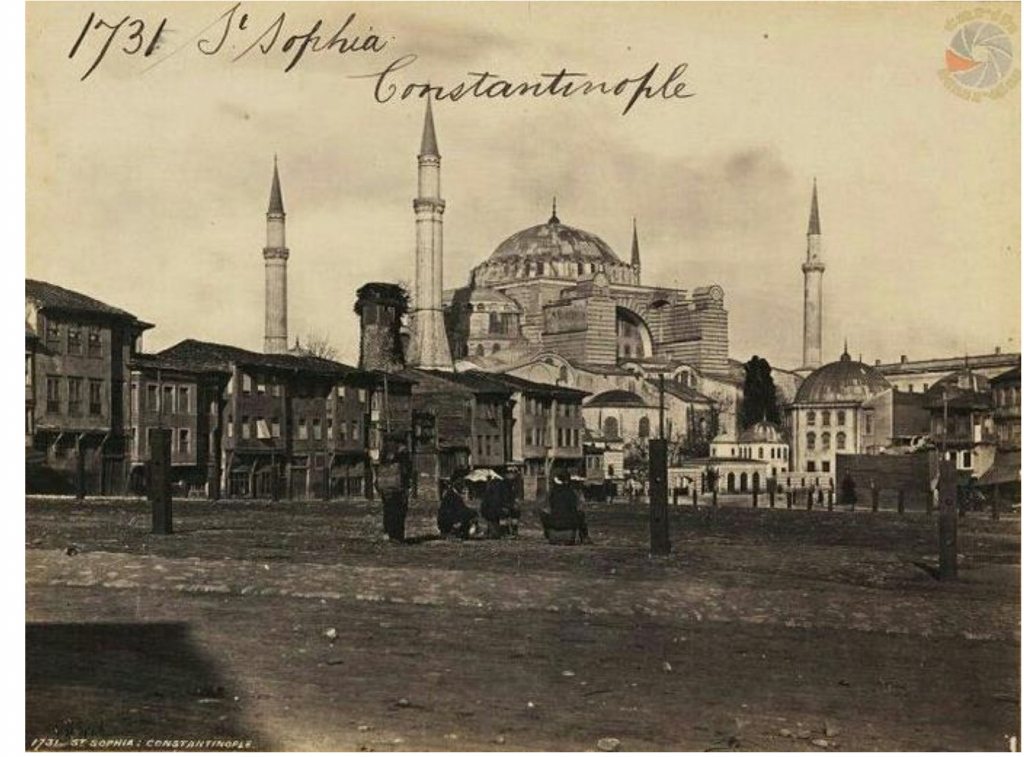
Figure 2. Photograph of Hagia Sophia from the year 1850